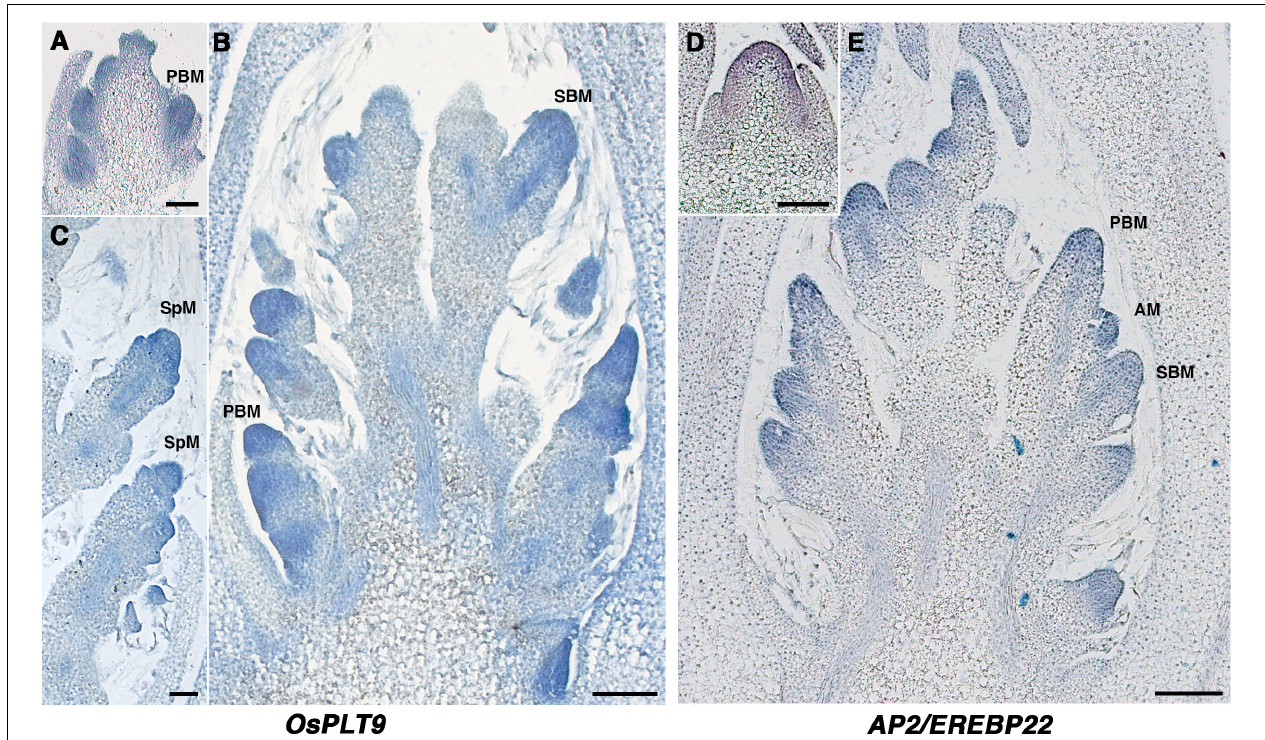
FIGURE 2 | Spatial expression pattern of the OsPLT9 and AP2/EREBP22 genes in the young developing panicle using in situ hybridization. (A) OsPLT9 transcript signal in the PBM. (B) OsPLT9 transcript signal in the developing panicle with elongating primary branches bearing axillary meristems and secondary branches. (C) OsPLT9 transcript signal in spikelet meristems. (D) AP2/EREBP22 transcript signal in the rachis meristem. (E) AP2/EREBP22 transcript signal in the developing panicle with elongating primary branches bearing axillary meristems and secondary branches. PBM, primary branch meristem; AM, axillary meristem; SBM, secondary branch meristem; SpM, spikelet meristem. Scale: 100 µ